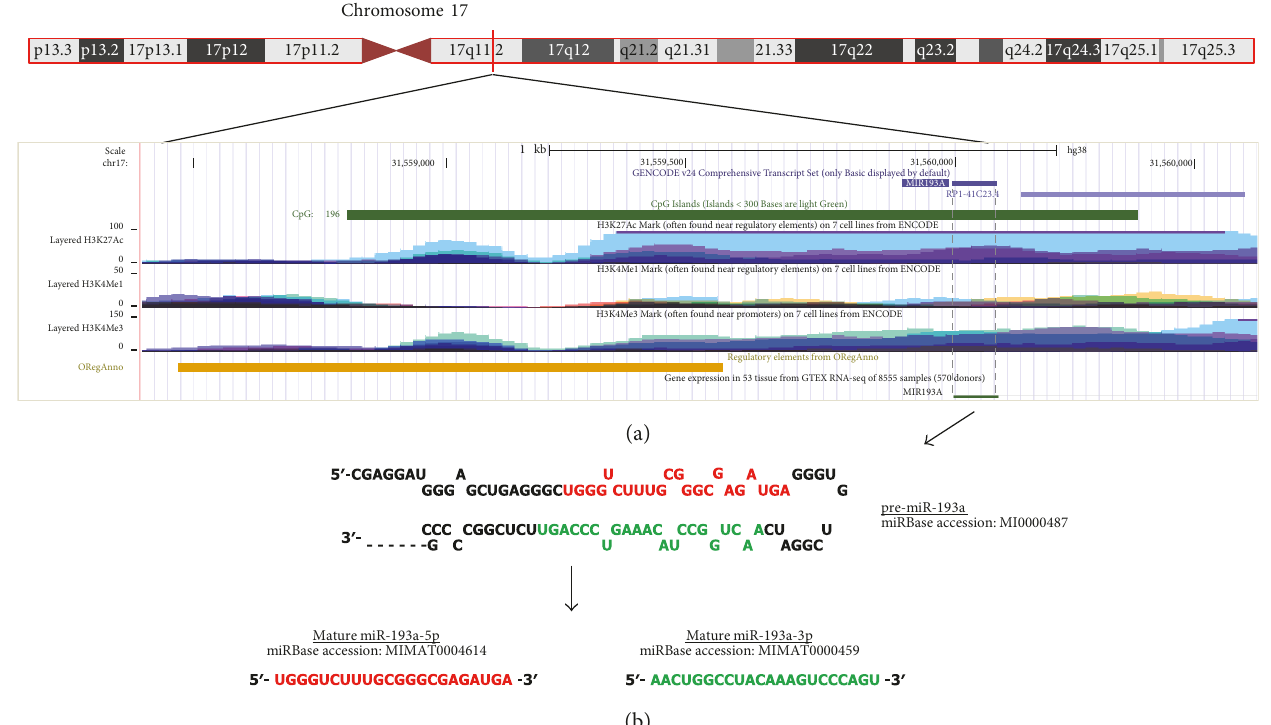
Figure 1: Genomic location of miR-193a coding sequence, stem-loop hairpin structure of pre-miR-193a and miR-193a-3p/miR-193a-5p sequences. (a) The analysis of the genomic region coding miR-193a referred to Genome Browser (https://genome-euro.ucsc.edu/). MIR193a coding sequence is located on human chromosome 17q11.2 characterized by a typical CpG island (in green). The layered H3K27Ac, H3K4Me1, and H3K4Me3 show the levels of histone marks across the genome in 7 cell lines (data obtain from ENCODE on the basis of ChiP-seq assay). By default, this track displays data from a number of cell lines in the same vertical space and each of the cell line is associated with a particular color. The regulatory element (in orange) is described as transcription factor binding sites by ORegAnno (open regulatory annotation). (b) The MIR193a gene is transcribed into a precursor (pre-miR-193a) with 88 nucleotides that is processed during miRNA biogenesis to yield mature miR-193a-5p (in red) and mature miR-193a-3p (in green) with 22 nucleotides in